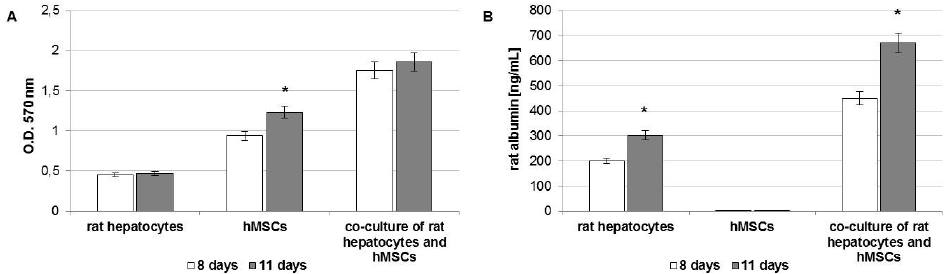
Figure 2. ( A ) Methyl thiazolyl-tetrazolium (MTT) assay; ( B ) albumin enzyme-linked immunosorbent assay (ELISA) assay on three-dimensional (3D) cultures of rat hepatocytes, hMSCs, and rat hepatocytes with hMSCs (ratio 1:1) after 8 and 11 days of culture in the bioreactor system. Data are presented as the mean ˘ standard deviation ( n = 3 per group). * p value ď 0.05.